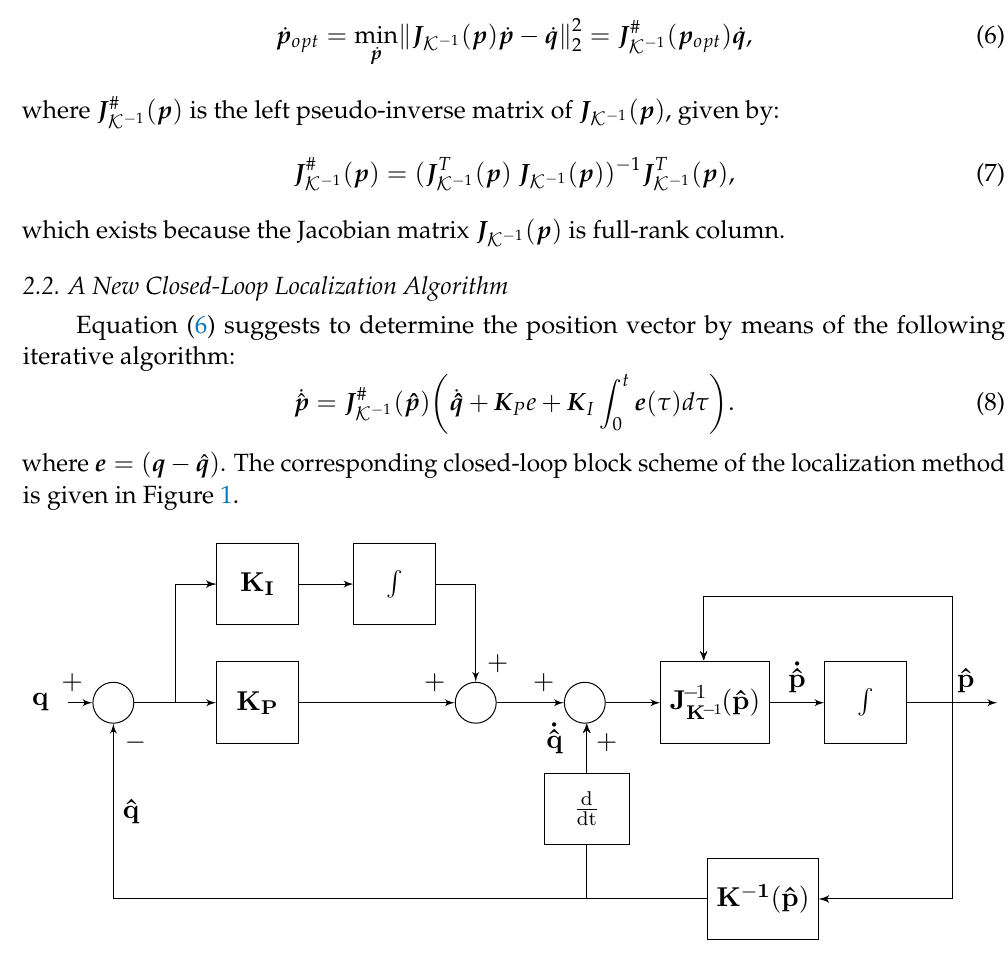
Figure 1. Block scheme of the localization